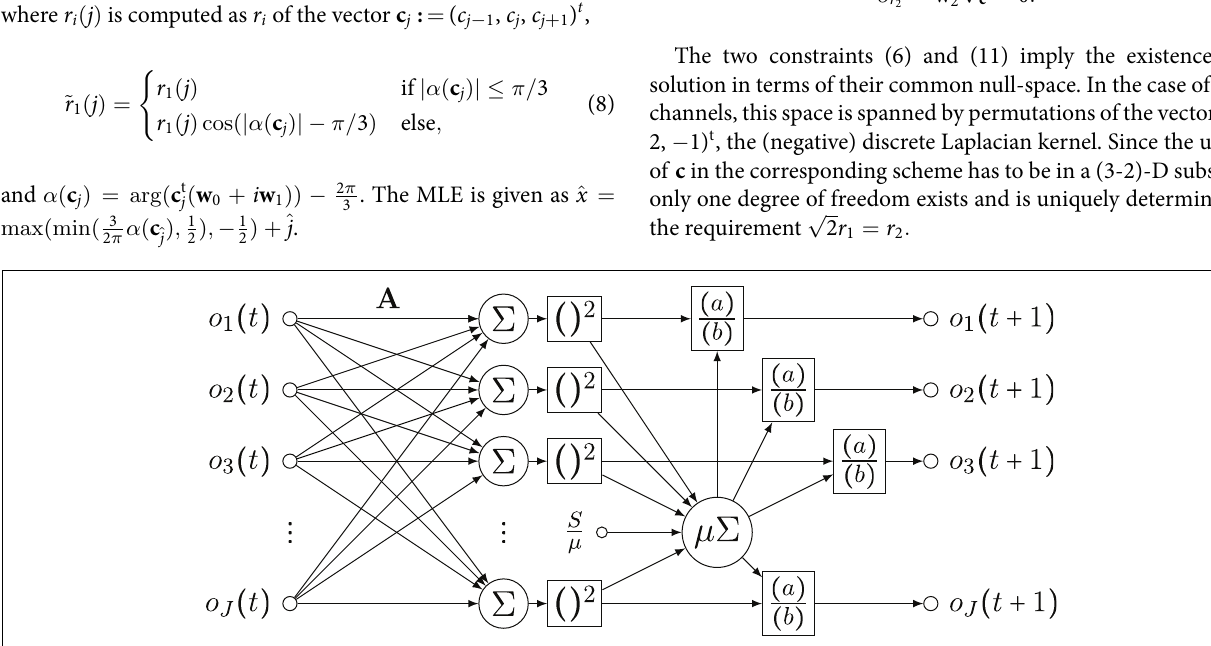
FIGURE 5 | Diagram of the recurrent network for the readout of population codes (Denève et al., 1999) .